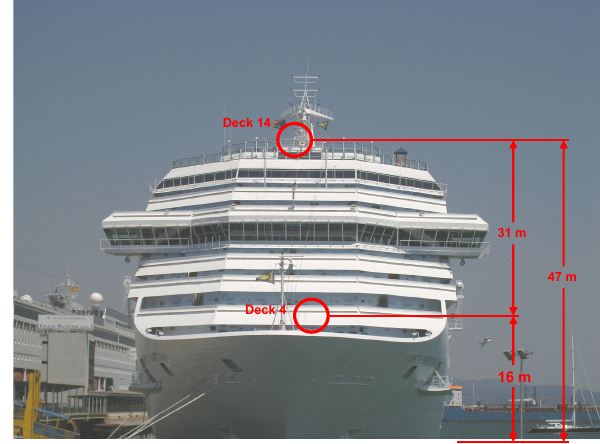
Fig. 1. Frontal view of Costa Fortuna with the locations for the instrumental set-up.